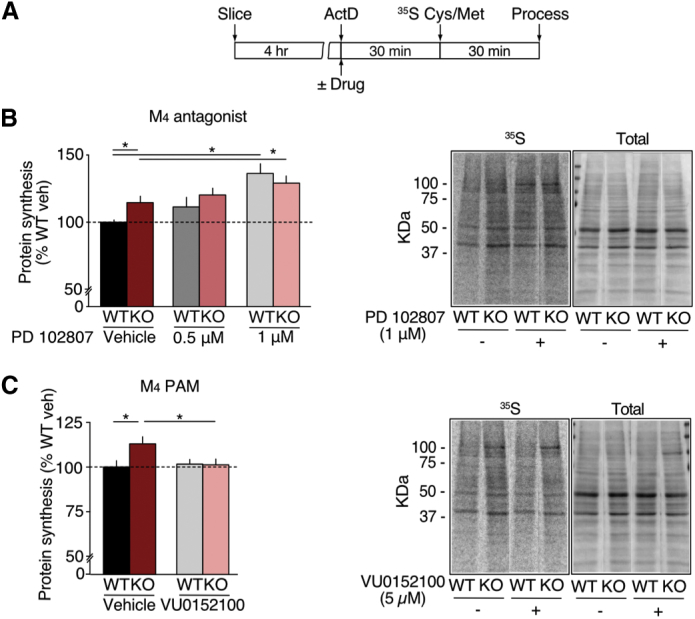
Enhancement of M4 Normalizes Excessive Protein Synthesis in the Fmr1−/y Hippocampus(A) Time course for metabolic labeling experiments.(B) Treatment with the M4 antagonist PD 102807 (0.5 μM or 1 μM) significantly increases protein synthesis in both WT and Fmr1−/y slices (WT vehicle = 100% ± 1.66%, WT PD 0.5 μM = 111.35% ± 7.16%, WT PD 1 μM = 136% ± 7.17%, KO vehicle = 114.59% ± 4.77%, KO PD 0.5 μM = 120.29% ± 5.02%, KO PD 1 μM = 129.05% ± 5.40%, ANOVA treatment ∗p < 0.0001, WT veh versus KO veh ∗p = 0.0379, WT veh versus WT PD 1 μM ∗p = 0.0009, KO veh versus KO PD 1 μM ∗p = 0.0065, n = 8). Example autoradiograph of slice homogenates shows upregulation of 35S-labeled proteins with M4 antagonist. Total protein stain of the same blot is shown for comparison.(C) Enhancement of M4 with VU0152100 (5 μM) results in selective reduction of protein synthesis in the Fmr1−/y hippocampus, but no change in WT (WT veh = 100% ± 3.12%, KO veh = 114.2% ± 3.47%, WT VU = 101.7% ± 2.33%, KO VU = 101.3% ± 3.05%, ANOVA genotype × treatment ∗p = 0.0456, WT veh versus VU p = 0.6580, KO veh versus VU ∗p = 0.013, n = 16). Example autoradiograph shows a reduction of 35S-labeled proteins in Fmr1−/y slices upon incubation with M4 PAM. Total protein stain of the same blot is shown for comparison. n = number of littermate pairs. Error bars indicate SEM.